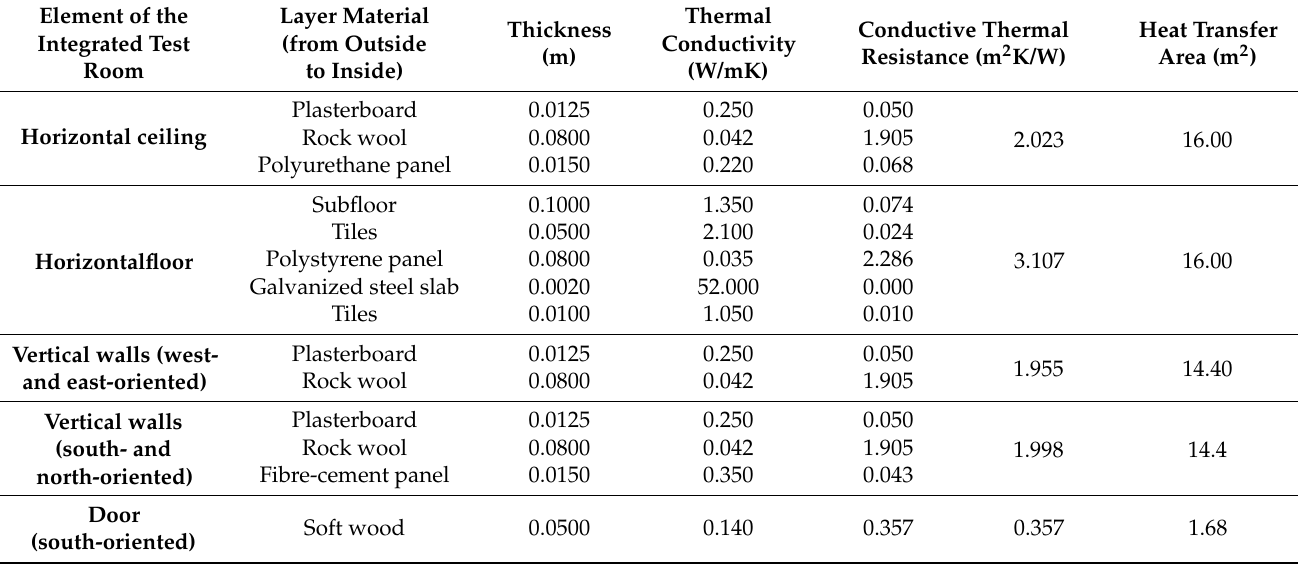
Table 2. Integrated test room envelope’s characteristics.